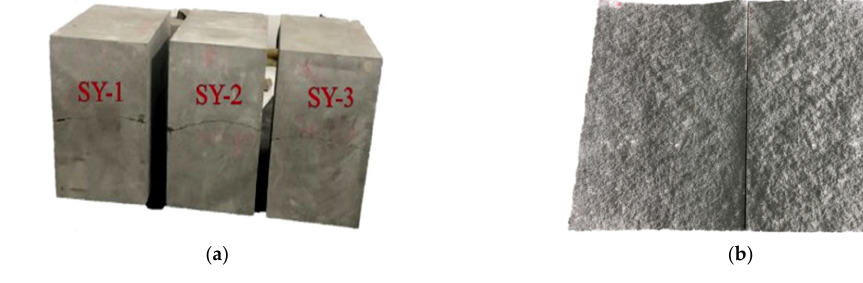
Figure 1. Sandstone specimen ( a ) and rough fracture surface ( b ). Table 2. Physical and mechanical parameters of sandstone specimens.